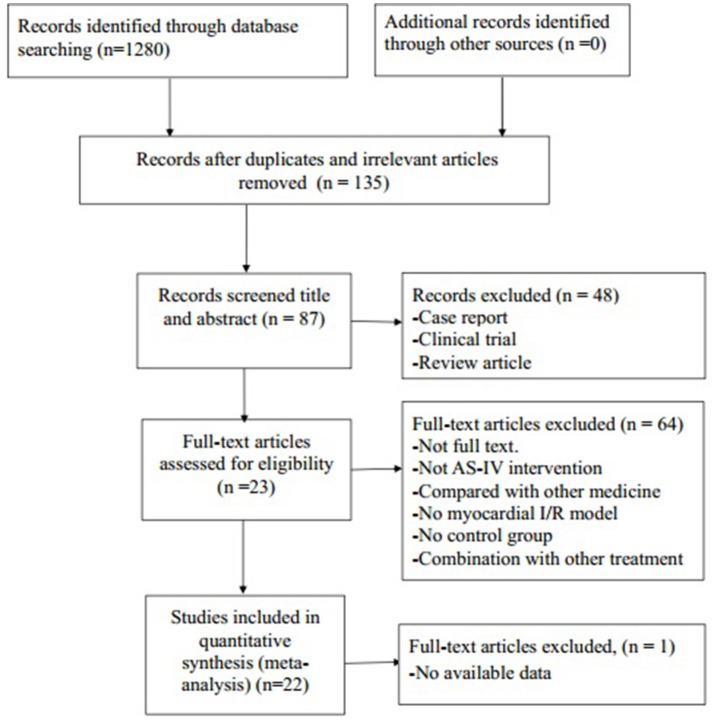
Summary of the process for identifying candidate studies.